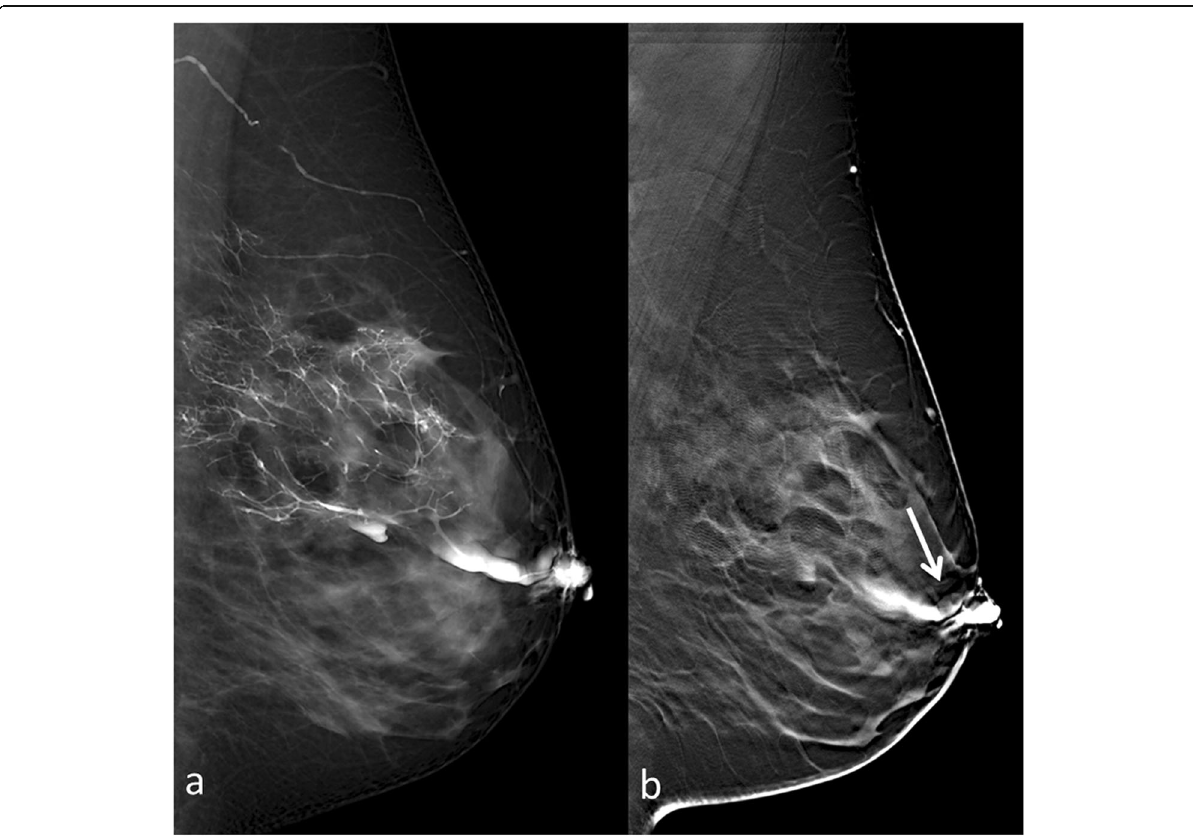
Fig. 1 a Full-field digital (FFD)-galactography. b Digital breast tomosynthesis (DBT)-galactography. Intraductal papilloma of the left breast in a 43- year-old patient. The intraductal lesion was not identified on FFD-galactography. Thin section DBT-galactography allows the identification of the intraductal papilloma detectable as a small filling defect